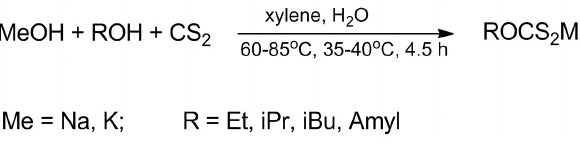
Figure 1. Reaction of alkali alkyl xanthate synthesis.